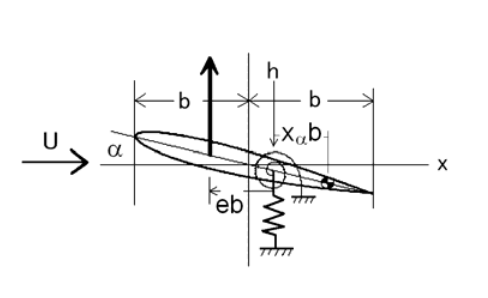
Fig 1. Typical wing